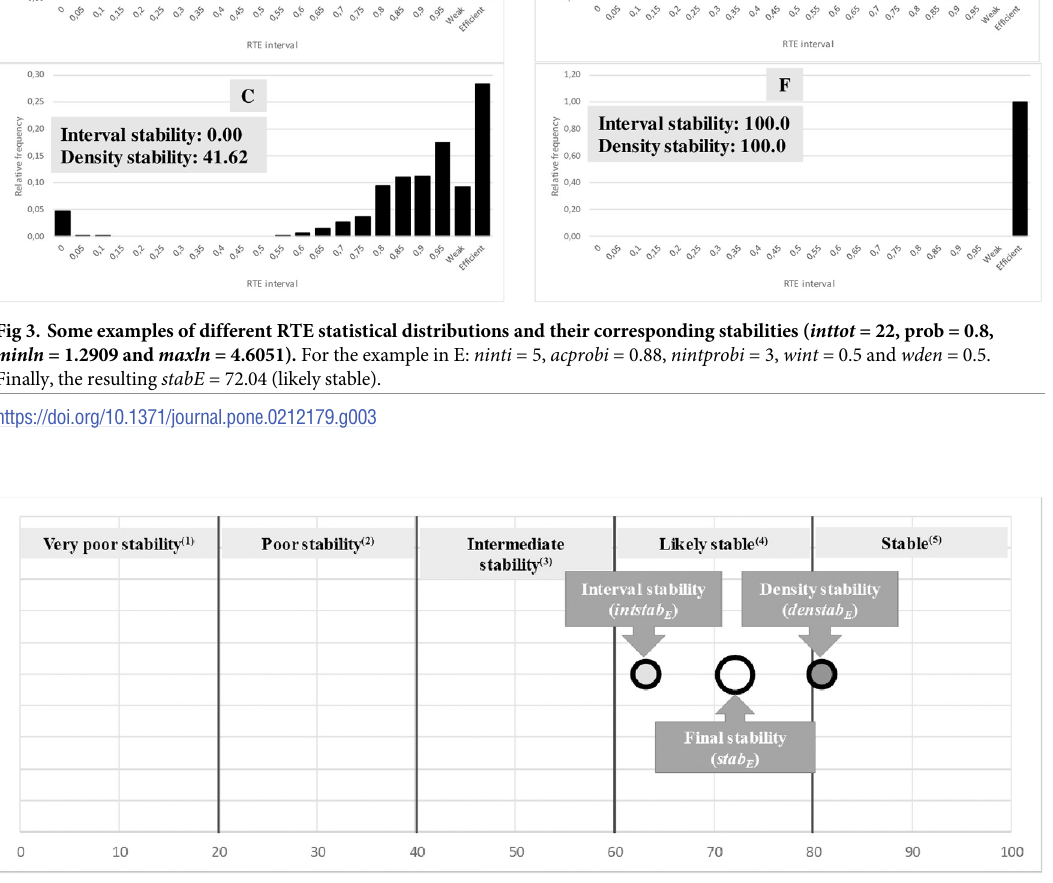
= 63.13, circle with the E